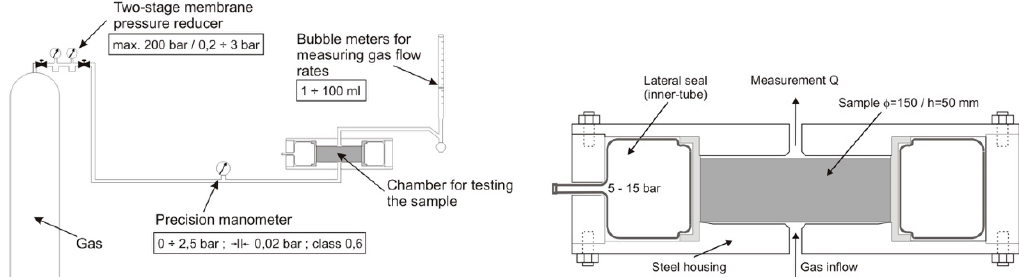
Figure 1. Permeability Cembureau testing set-up of the sample chamber.